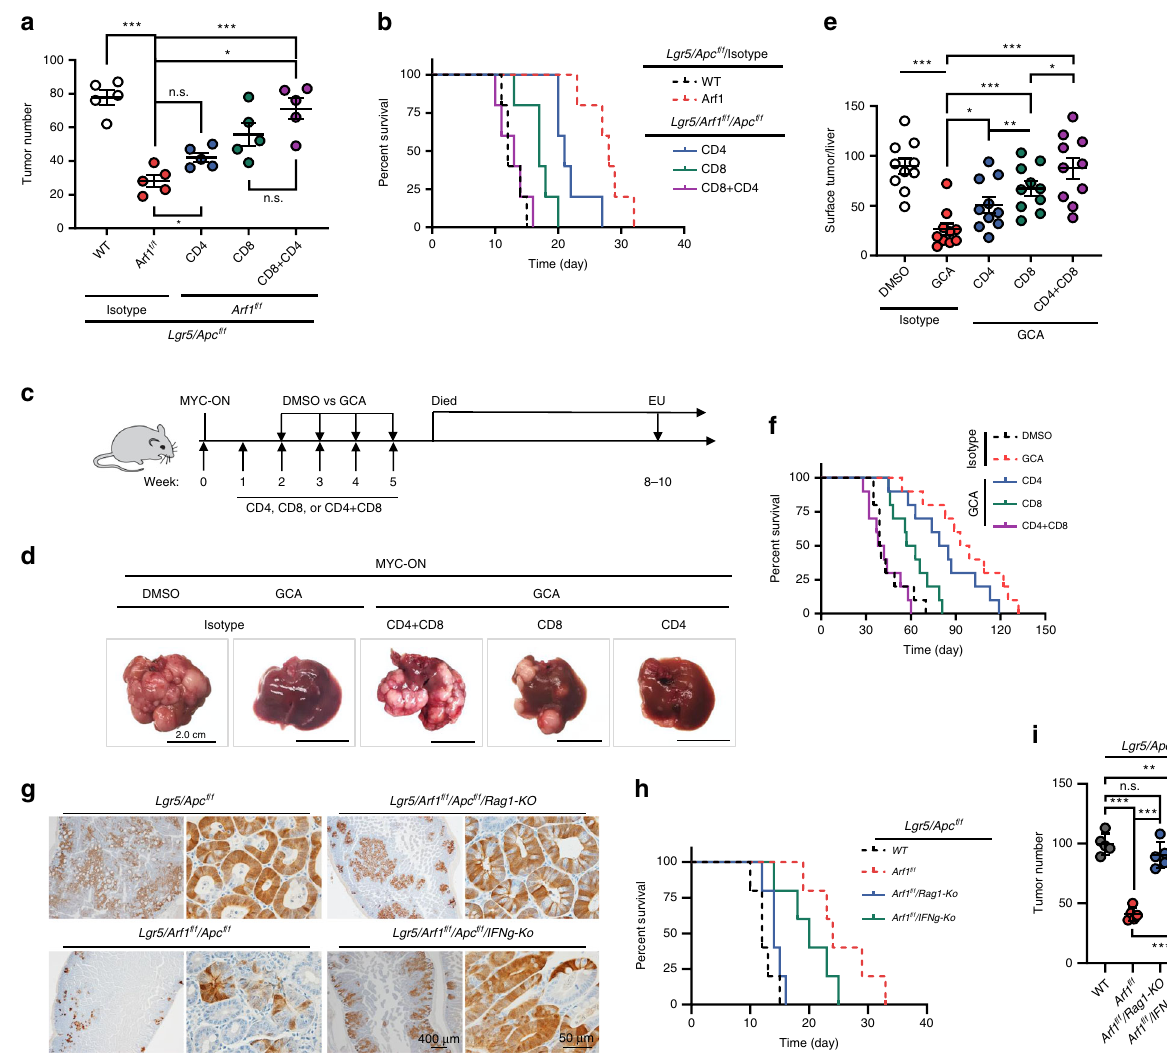
Fig. 4 Prolonged survival of Lgr5/Apc and MYC-ON mice depends on the T cells. a Intestinal tumor number in mice of the indicated genotypes treated with anti-CD4 (CD4) or/and anti-CD8 (CD8) antibodies. b Survival curves of mice with the indicated genotypes and treatments ( n = 5 mice each group; * p < 0.05, ** p < 0.01, *** p < 0.001, t -test; repeat two independent experiments). c Experimental setup for MYC-ON liver tumor mice treated with the indicated reagents. d Representative liver images of MYC-ON mice treated with the indicated reagents. Scale bars: 2.0 cm. e Liver surface tumor counts of MYC-ON treated with the indicated reagents ( n = 10 mice per group; * p < 0.05, ** p < 0.01, *** p < 0.001, t -test; pooled two independent experiments). f Survival curves of MYC-ON mice treated with the indicated reagents ( n = 10 mice per group; * p < 0.05, ** p < 0.01, *** p < 0.001, t -test; pooled two independent experiments). g Immunohistochemical staining of GFP in the indicated genotypes ( n = 5 mice per group). h – i Percent of survival ( h ) and intestine tumor number ( i ) in the indicated mice ( n = 5 mice each group; ** p < 0.01, *** p < 0.001, t -test; repeat two independent experiments). Data are shown as the mean ± SEM. * p < 0.05, ** p < 0.01, *** p < 0.001 by Student ’ s t -test. ON liver tumor mice compared with DMSO-treated mice (Fig. 5l). LRP1 and CD11c were colocalized in the Arf1 inhibitor-treated MYC-ON mouse liver (Fig. 5l), suggesting that Arf1 inhibition induced LRP1 in DCs. Collectively, these data indicate that Arf1 inhibition triggers ER stress, and induces DAMPs and DC in fi ltration. Arf1-KO induces anti-tumor immune responses through DAMPs . To examine whether DAMPs are essential for the anti- tumor immune response of Arf1 ablation, we fi rst interfered with the action of ATP and HMGB1 in Lgr5/Arf1/Apc intestinal CSC mice by administering ARL61756 (ARL), oxATP, suramin, and the Toll-like receptor 4 (TLR4) inhibitor (Fig. 6a, b). ARL is an inhibitor of ecto-ATPases that enhances the action of ATP by arti fi cially increasing the extracellular ATP concentration 33 . tested these inhibitors in MYC-ON mice, and similarly found that NATURE COMMUNICATIONS| (2020) 11:220